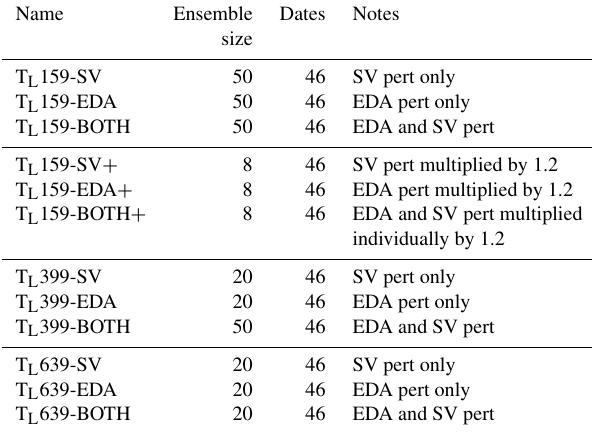
Table 4. Experiments conducted for this study. The experiment name includes the resolution used as well as the type of initial state perturbations (pert) used. The ensemble sizes, the number of ensem- ble initialization dates, and notes regarding the specific experiments are also